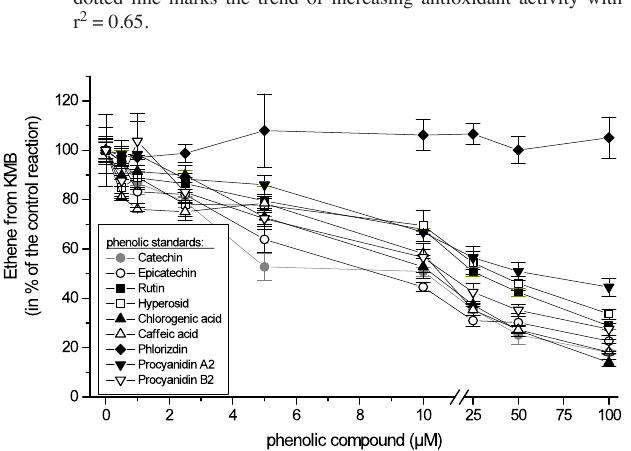
Fig. 4: Dose response plots of standards determined in the X/XOD/KMB test. Conditions see captions of Fig. 2.